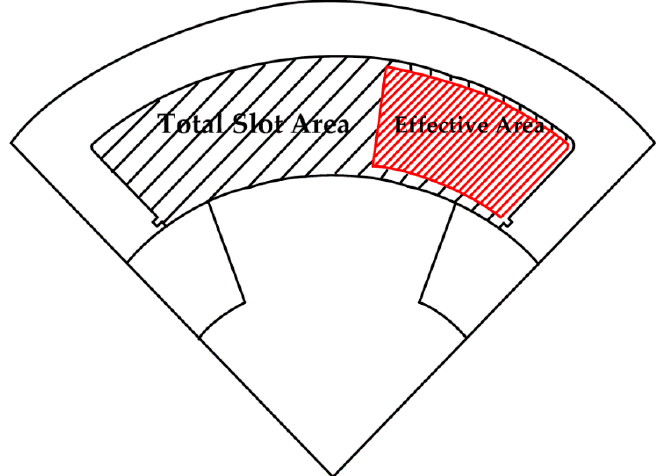
Figure 4. Winding effective area.